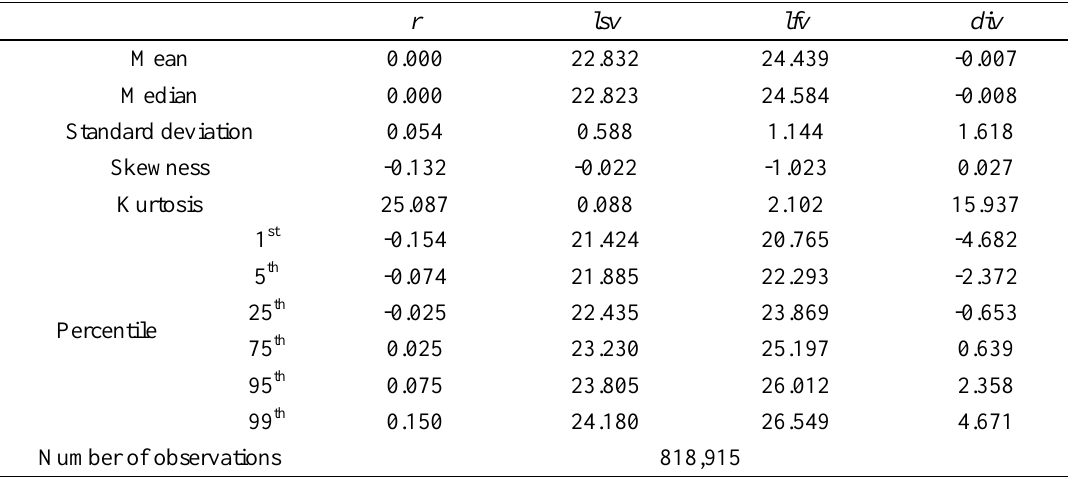
Table 1 : Summary